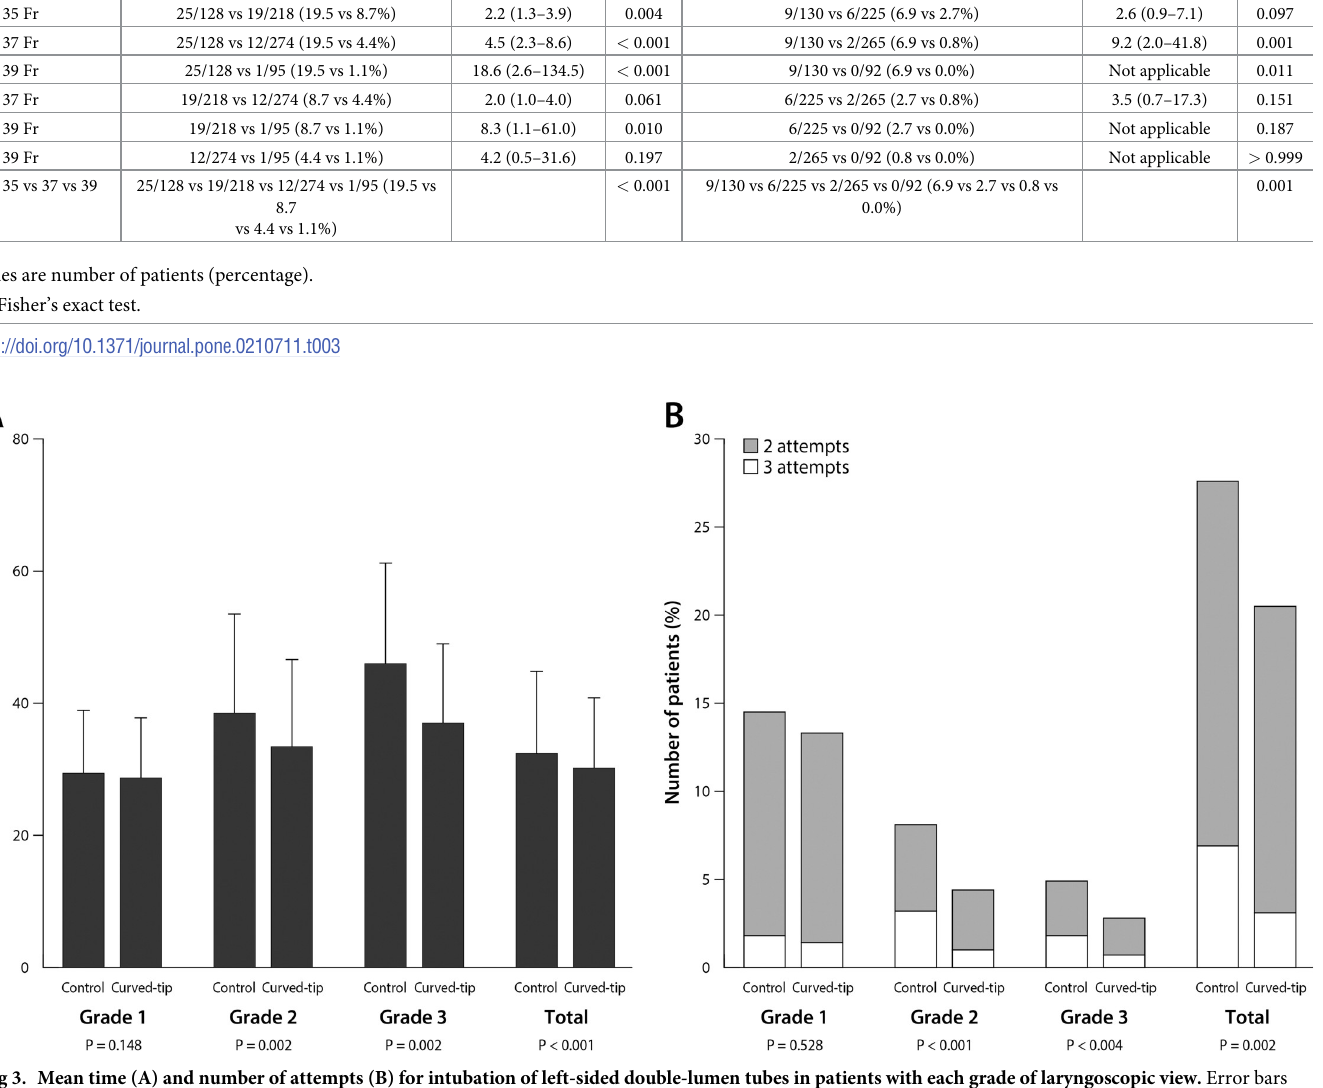
Table 3. Within-group comparisons of the incidence of the right bronchial misplacement between the uses of left-sided double-lumen tubes of different sizes.